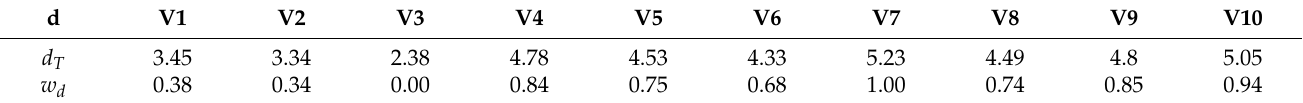
Table 4. Sums of the correlation degree and normalized result of ten variables.